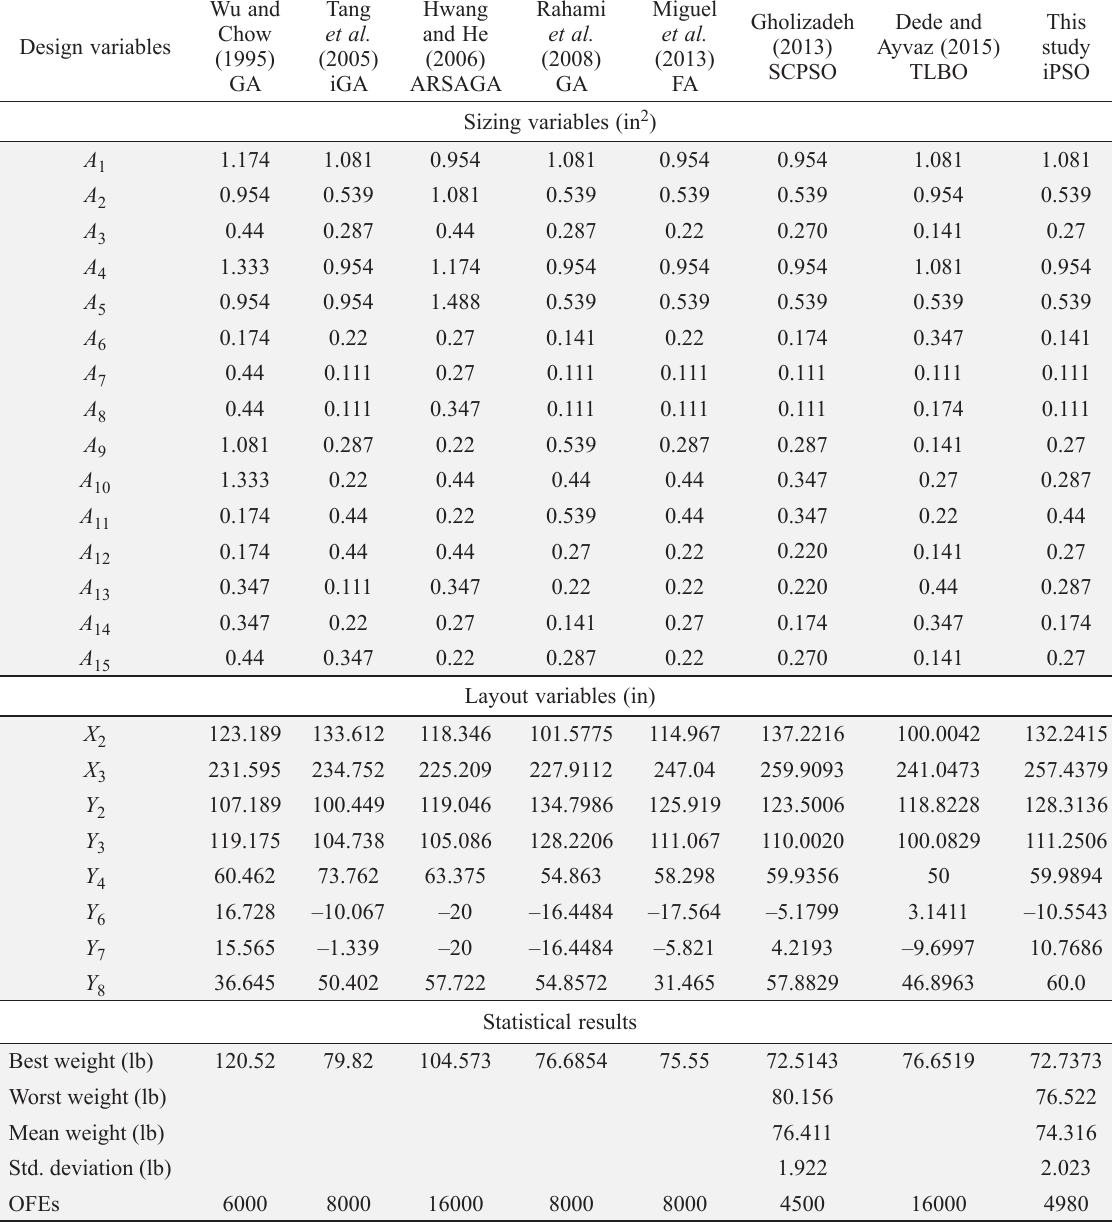
Table 2. Comparison of the iPSO optimization results with the literature for the 15-bar truss problem